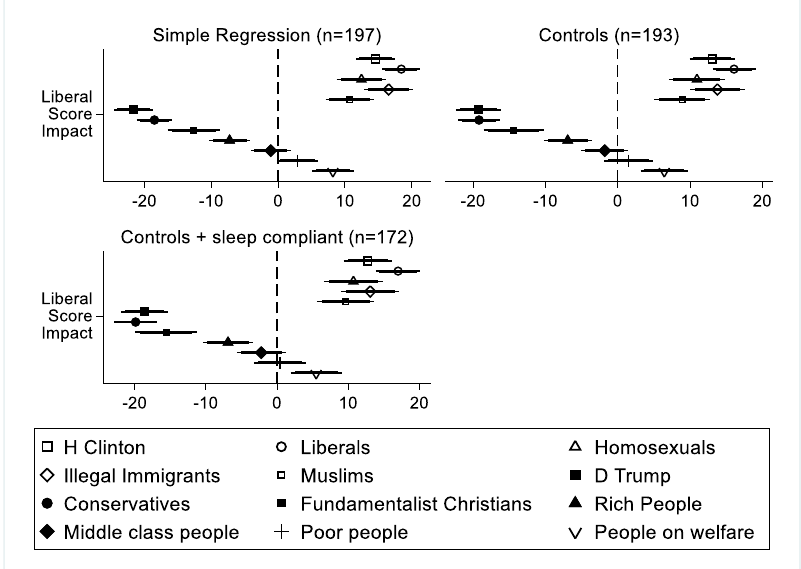
Figure A1. Balance Tests. Notes: Observations = 197. Point estimates represent coefficient estimates,  , on simple regression of variable listed on indicator variable for treatment assignment (SR = 0 or 1): Characteristic =  +  SR ) +  . Thin (thick) lines around point estimates represent the 95% (90%) confidence intervals. Measures assessed in these tests were derived from the recruitment database information.